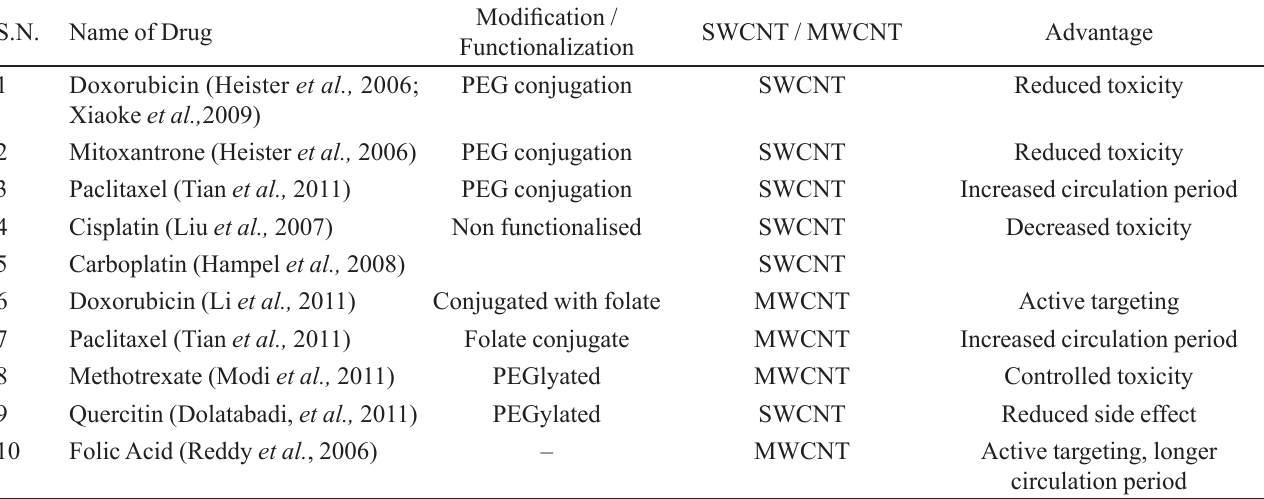
TABLE I - List of anticancer drugs delivered using CNTs